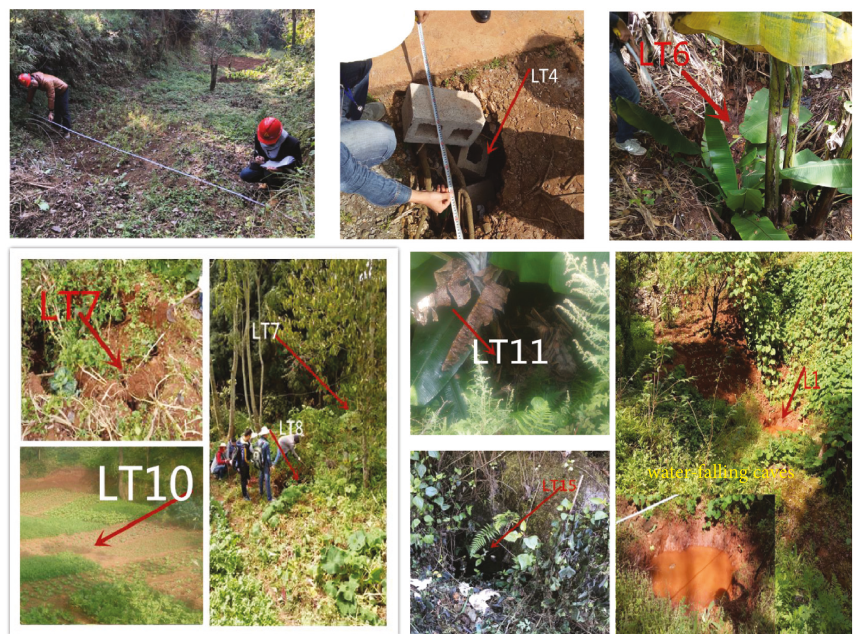
Figure 4: Morphological characteristics of karst collapse points and water-falling